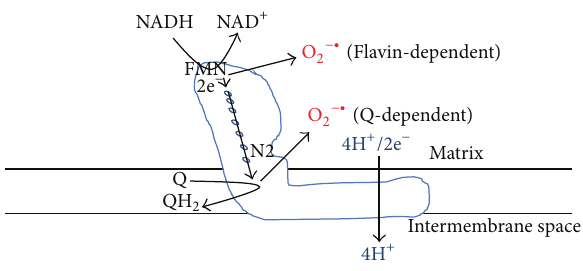
Figure 1: The three key roles of mitochondrial complex I: NADH oxidation and recycling, superoxide production, and proton pump- ing. Electrons from NADH are transported to CoQ via seven Fe-S clusters with the terminal one being N2 [6]. Superoxide could be produced at both the FMN-dependent site and the CoQ-dependent site